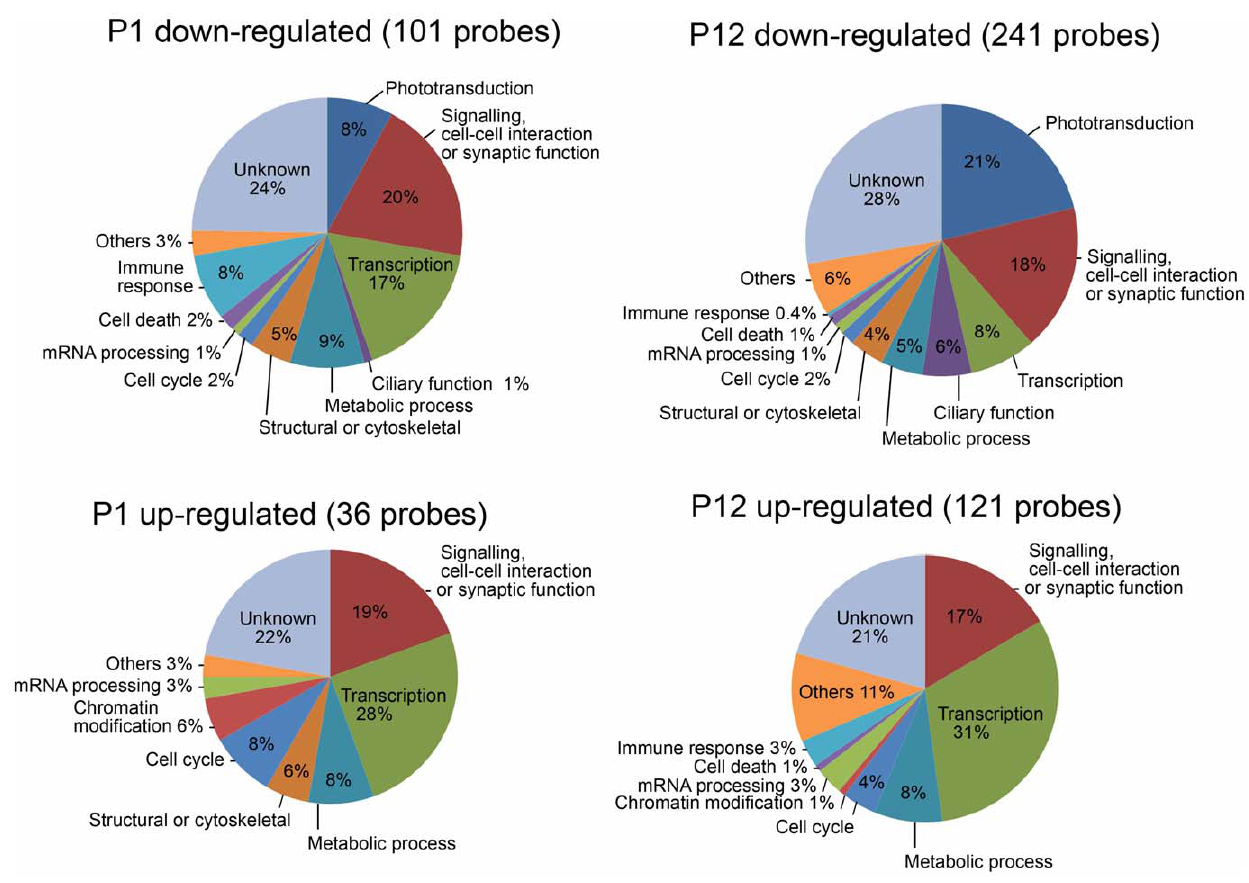
Figure 1. Categorization of the genes differentially expressed in the Otx2 CKO retina. According to gene ontology (GO) term annotation, the genes differentially expressed in the Otx2 CKO retinas at P1 and P12 were categorized into functional groups. We used GO term data on 101 probes with decreased expression in the Otx2 CKO at P1 (signal log ratio #2 1.0, signal intensity $ 50), 36 probes with increased expression in the Otx2 CKO at P1 (signal log ratio $ + 0.5, signal intensity $ 50), 241 probes with decreased expression in the Otx2 CKO at P12 (signal log ratio #2 2.5, signal intensity $ 100), and 121 probes with increased expression in the Otx2 CKO at P12 (signal log ratio $ + 2.5, signal intensity $ 100).